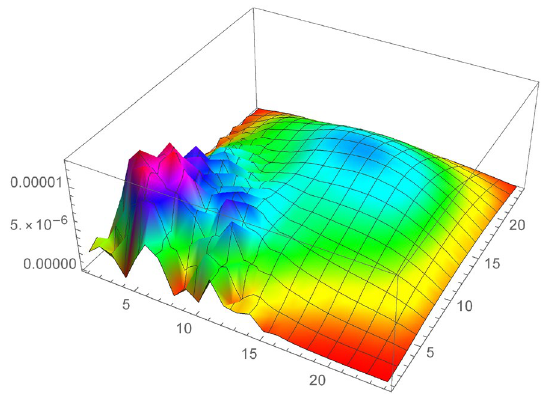
Figure 3. The Example 1 absolute error, when h = τ = 1 25 and γ = 0.1 .